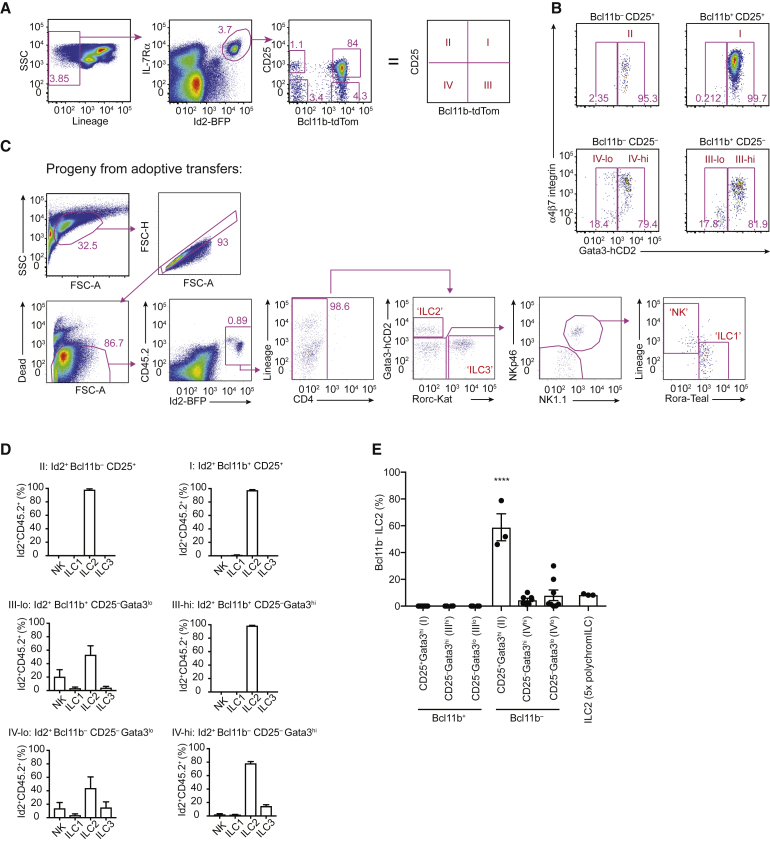
Identification of Heterogeneous Multipotent ILC Progenitors in the Bone Marrow(A) Representative flow-cytometry gating strategy for the characterization and purification of ILC progenitor subsets (populations I, II, IIIlo, IIIhi, IVlo, and IVhi) (see Table S1) from the bone marrow of 5x polychromILC mice.(B) Flow-cytometry gating strategy for the characterization and purification of ILC progenitor subsets (see A) from the bone marrow of 5x polychromILC mice.(C) Flow-cytometry gating strategy for ILC subsets in siLP arising from adoptive transfer of bone marrow progenitor populations from 5x polychromILC mice into sublethally irradiated Rag2−/−Il2rgc−/− recipients.(D) Flow-cytometry analysis of the ILC progeny generated in vivo after the individual adoptive transfers of progenitor cell populations (see A), purified from the bone marrow of 5x polychromILC mice, into Rag2−/−Il2rgc−/− recipients.(E) Proportion of Bcl11b− ILC2 progeny in siLP, derived from the adoptive transfer of purified cell populations (see A) into Rag2−/−Il2rgc−/− recipients. Statistical comparison to ILC2s from a 5x polychromILC mouse.Data are pooled from 2 independent experiments and represent mean ± SEM of 3–11 mice per group; ∗∗∗∗p < 0.0001 one-way ANOVA with Dunnett’s post hoc test.